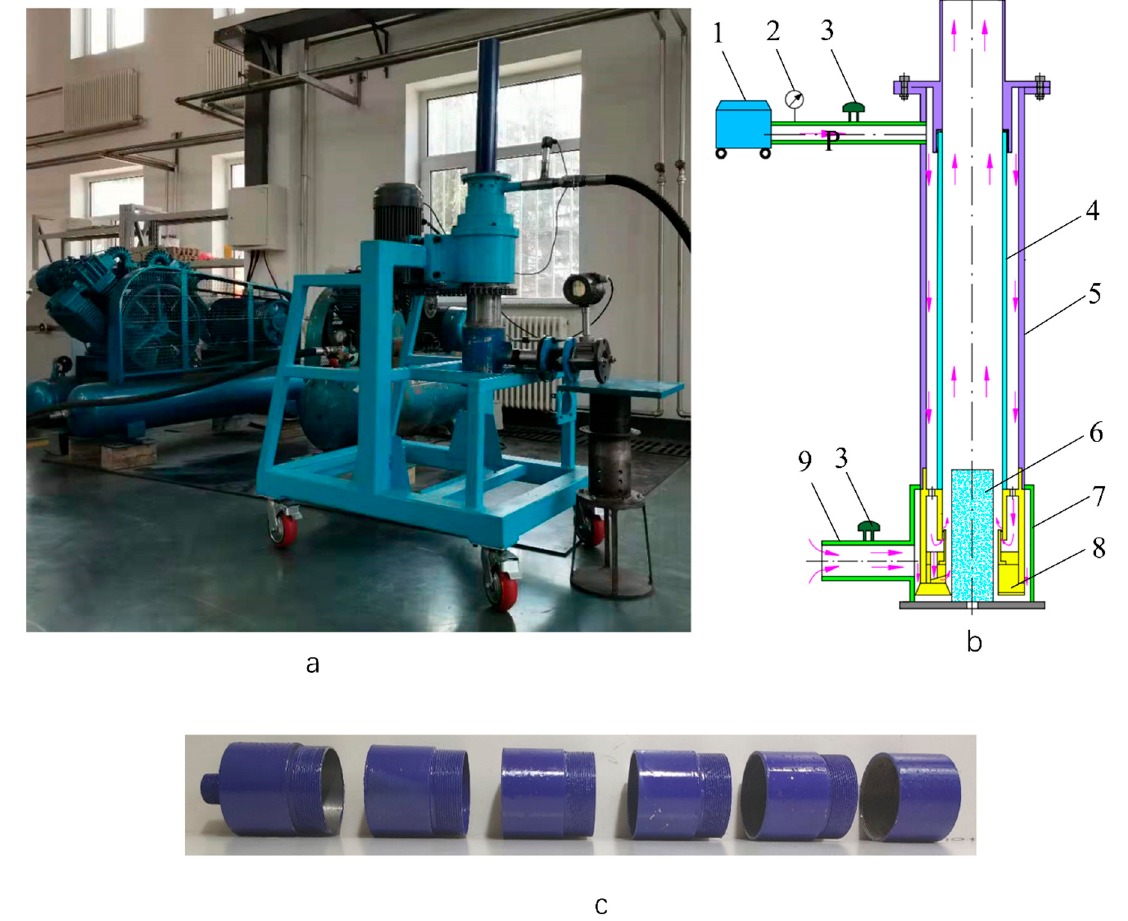
Figure 4. Equipment for testing ice drilling with air reverse circulation: ( a ) experiment table; ( b ) schematic; ( c ) ice cores; (1) air compressor; (2) pressure sensors; (3) vortex flow meter; (4) inner tube of drill bit; (5) outer tube of drill bit; (6) borehole wall; (7) ice core; (8) drill bit body; (9) suction tube.